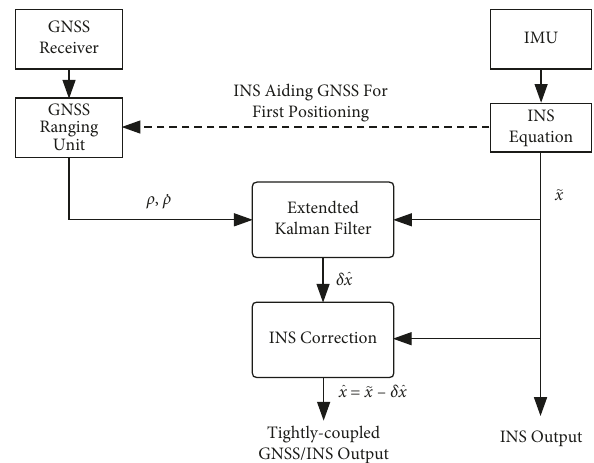
Figure 2: A common design for tightly coupled